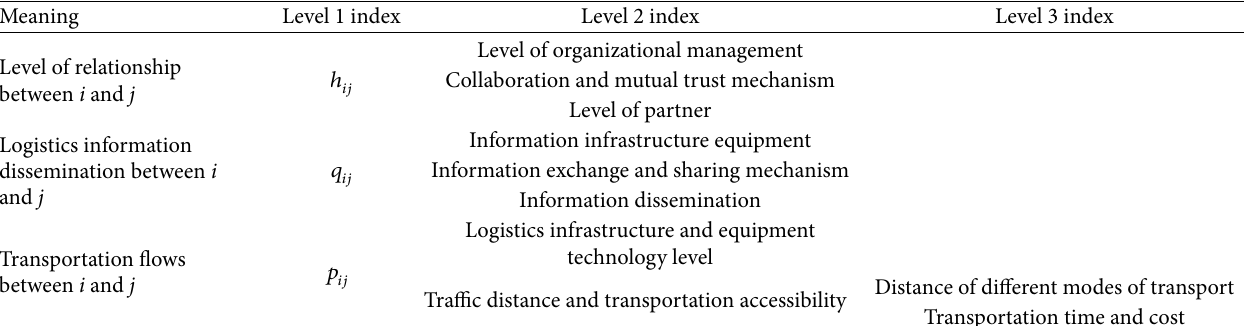
Table 2: Evaluation index of decision